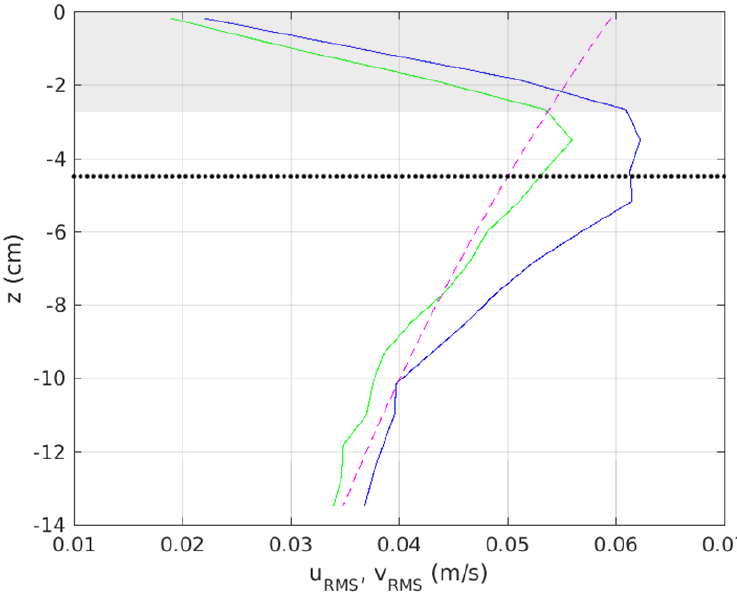
Figure 12. RMS velocity profiles computed from PIV velocity measurements under ice in trial 18, including u RMS (blue), v RMS (green), and theoretical profile for waves of this type in ice-free open water (magenta dashed). Black dotted line represents approximate lowest depth reached by ice–water interface; gray shaded region is depth range in which PIV data were corrupted by ice layer (see text).